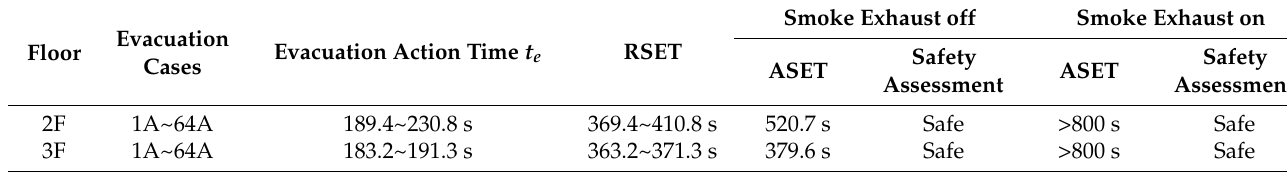
Table 7. ASET and RSET on the second and third floors.